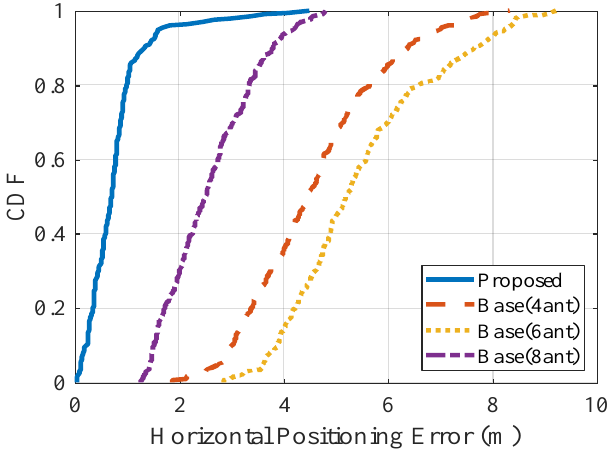
Figure 14. CDF of horizontal positioning error. Table 4. Average of horizontal positioning error (m).